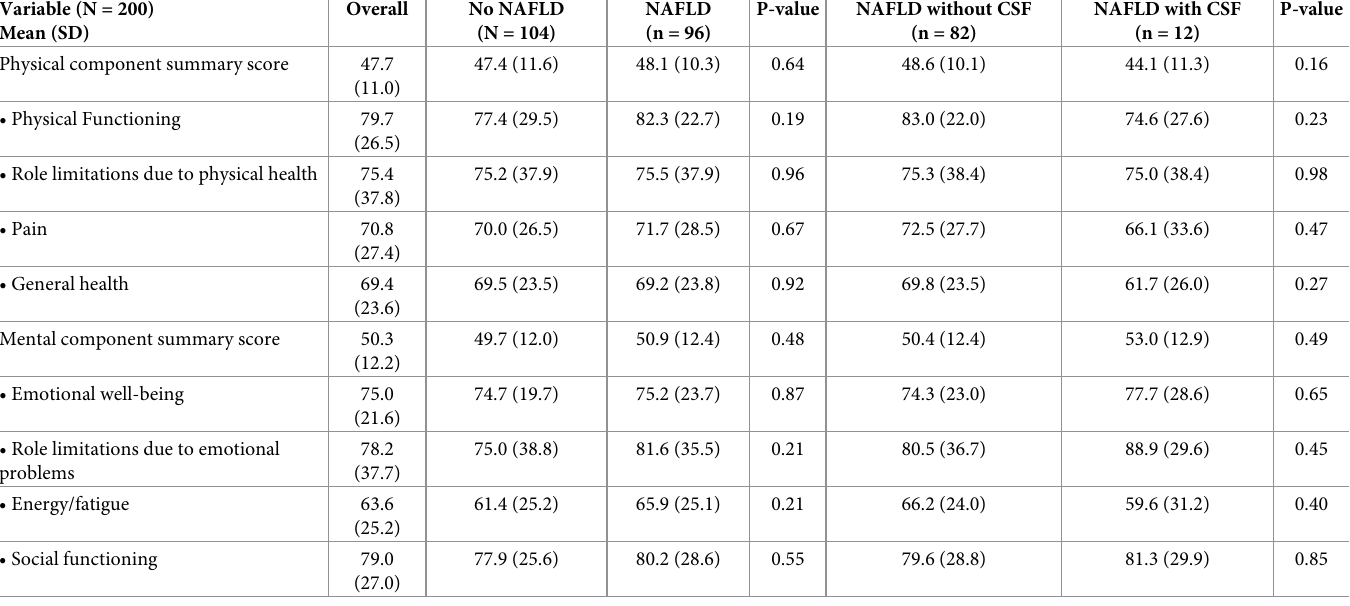
Mental component summary